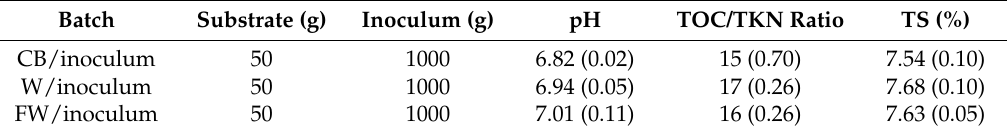
Table 2. Batch characteristics (mean values, with standard deviation values in brackets).